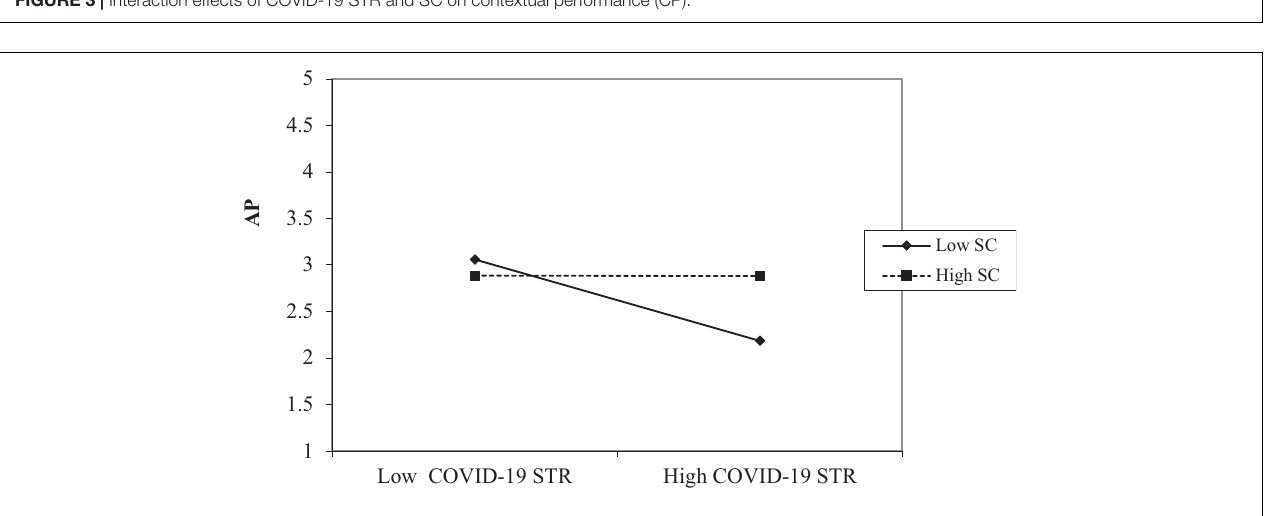
FIGURE 3 | Interaction effects of COVID-19 STR and SC on contextual performance (CP).